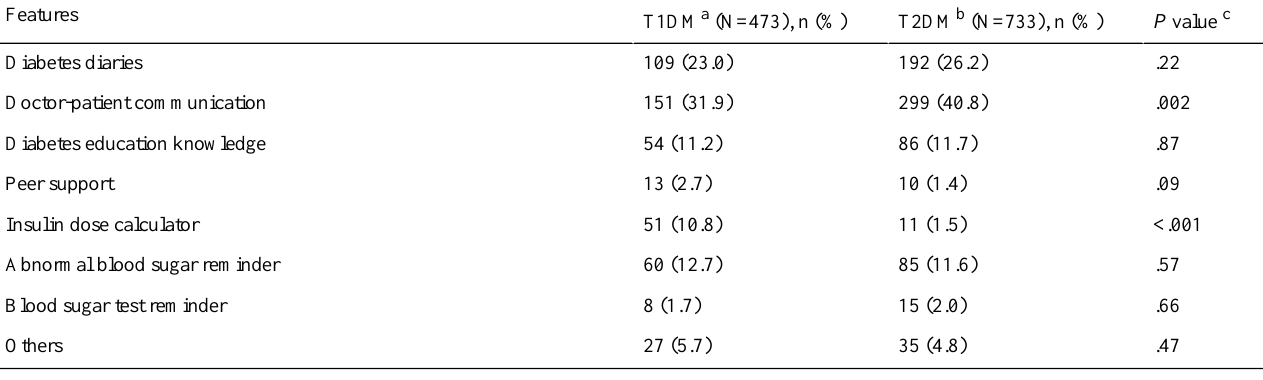
Table 3. App functions considered to be most important by patients with both T1DM and T2DM.